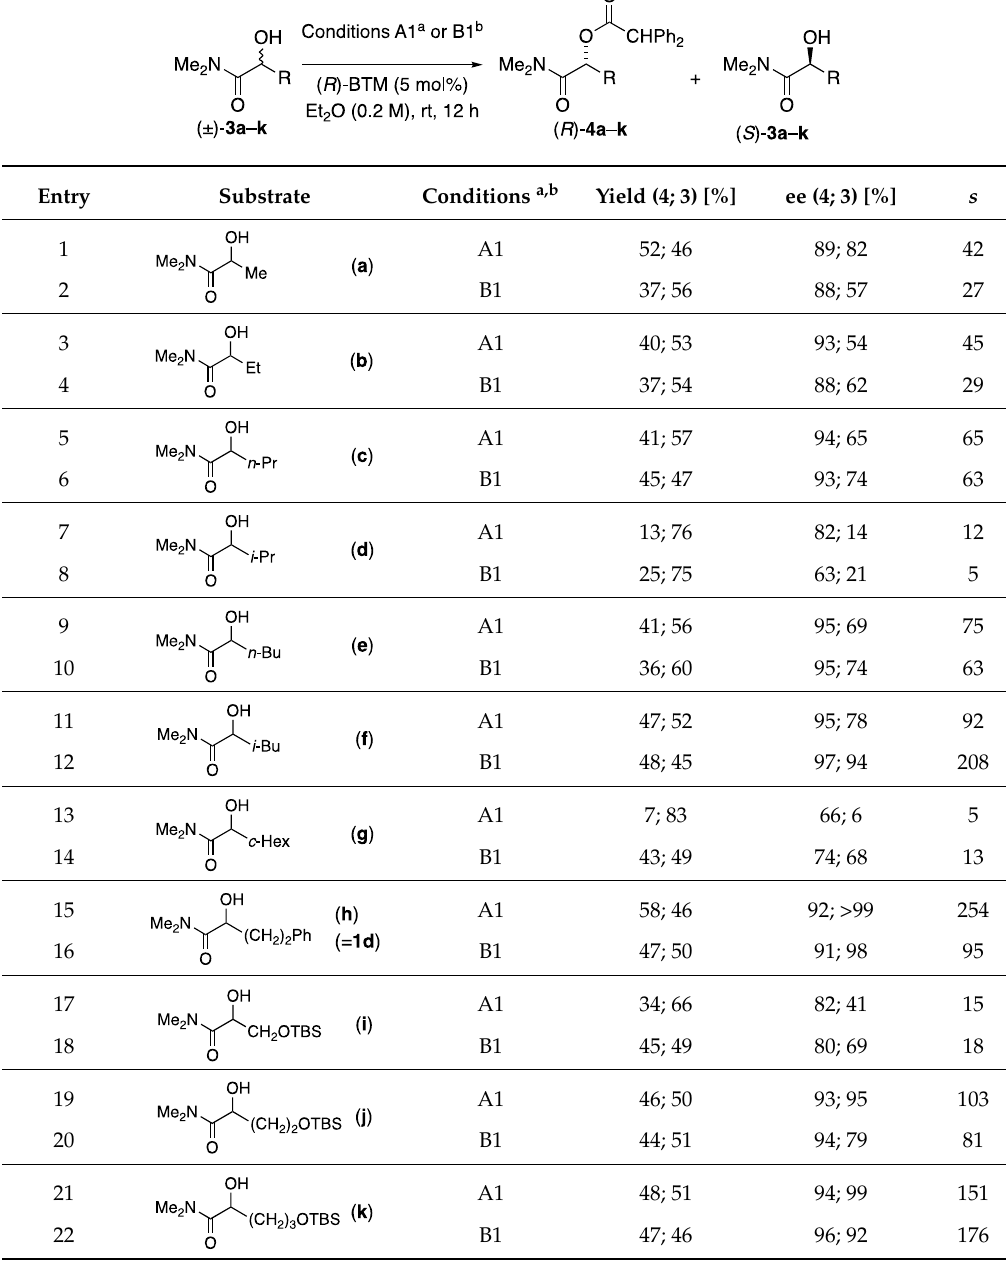
Table 2. KR of 2-hydroxy dimethylamide ((±)- 3a – 3k ).